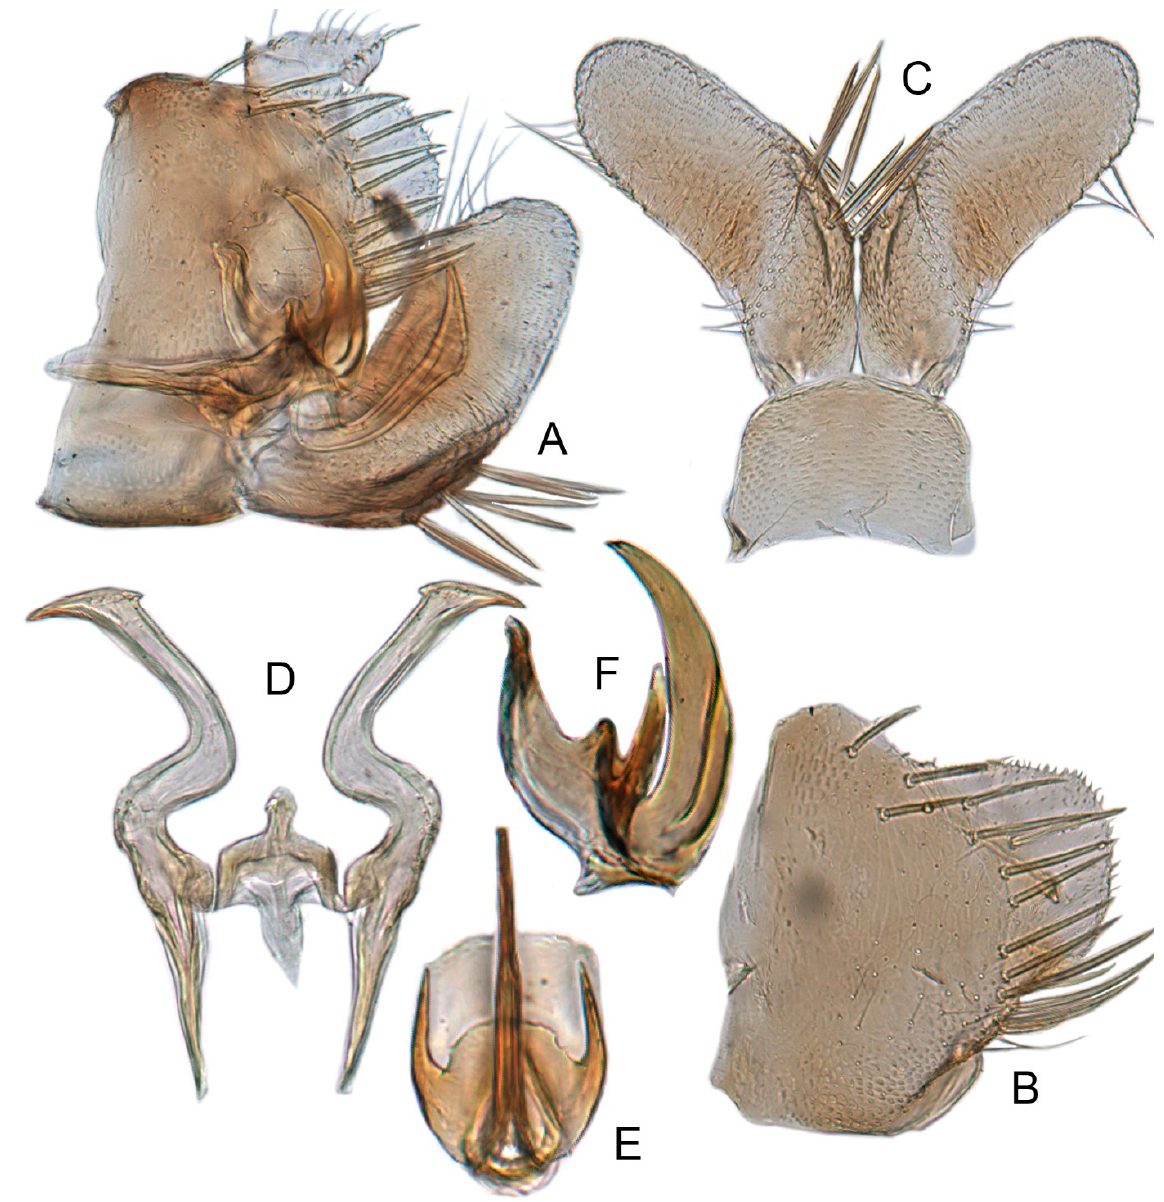
Figure 21. Xestocephalus limpidissimus sp. nov. ( A ) Male genital capsule, lateral view; ( B ) pygofer lobe, lateral view; ( C ) subgenital plates and valve, ventral view; ( D ) style and connective, ventral view; ( E ) aedeagus, posterior view; ( F ) aedeagus, lateral view.